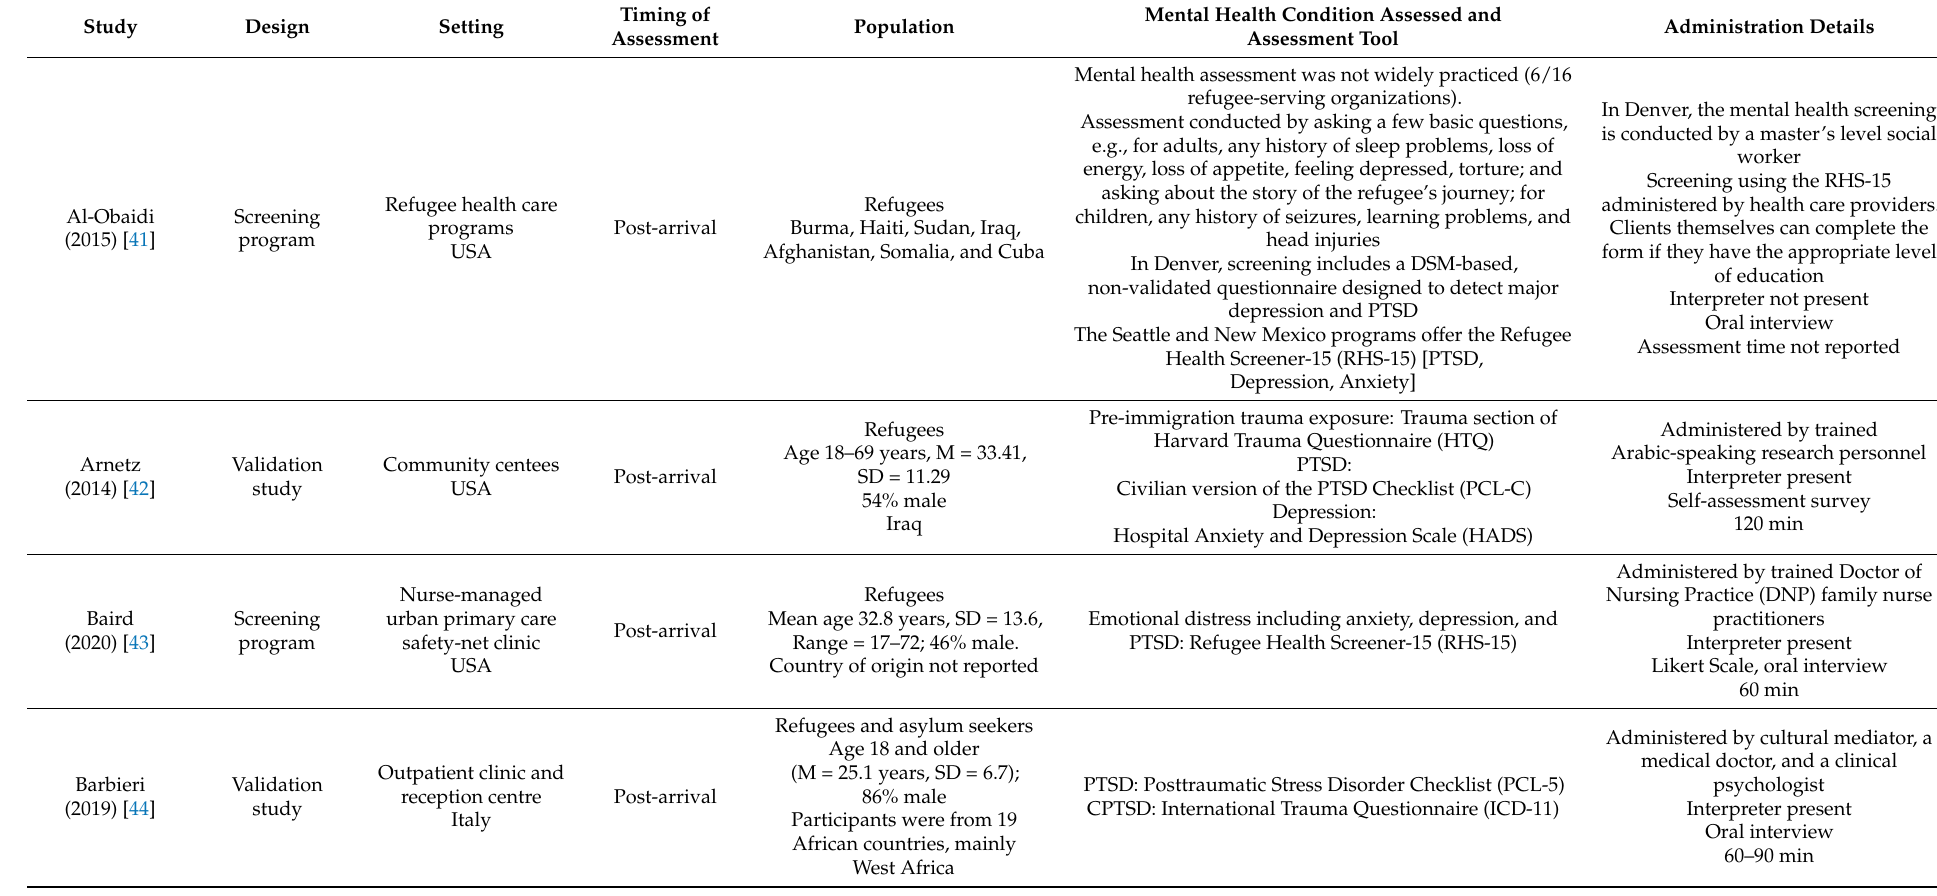
Table 2. Characteristics of included studies ( n =